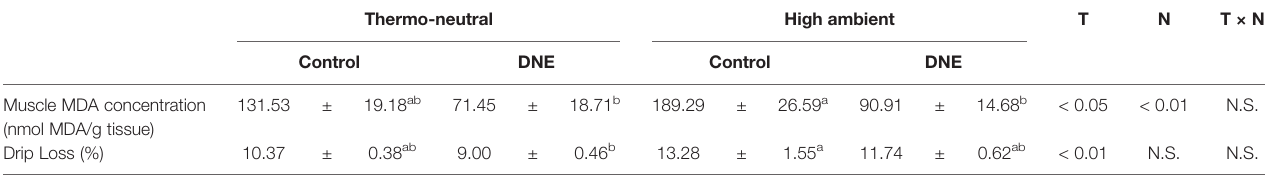
TABLE 3 | Effects of dietary supplementation with DNE on MDA concentration and drip loss in the skeletal muscle of broiler chickens under high temperature